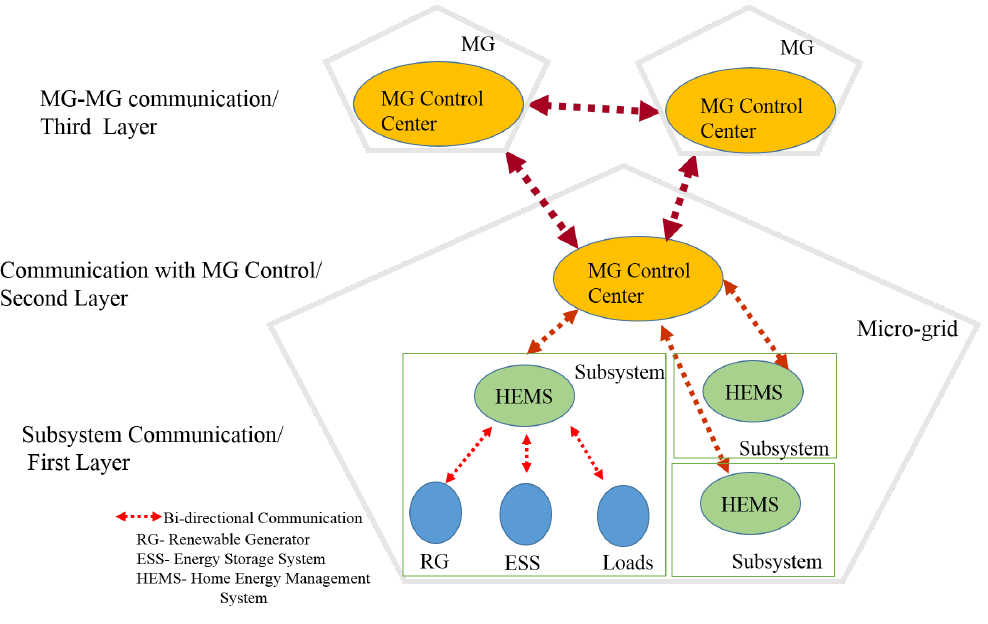
Figure 1. Hierarchical communication layers in micro-grid